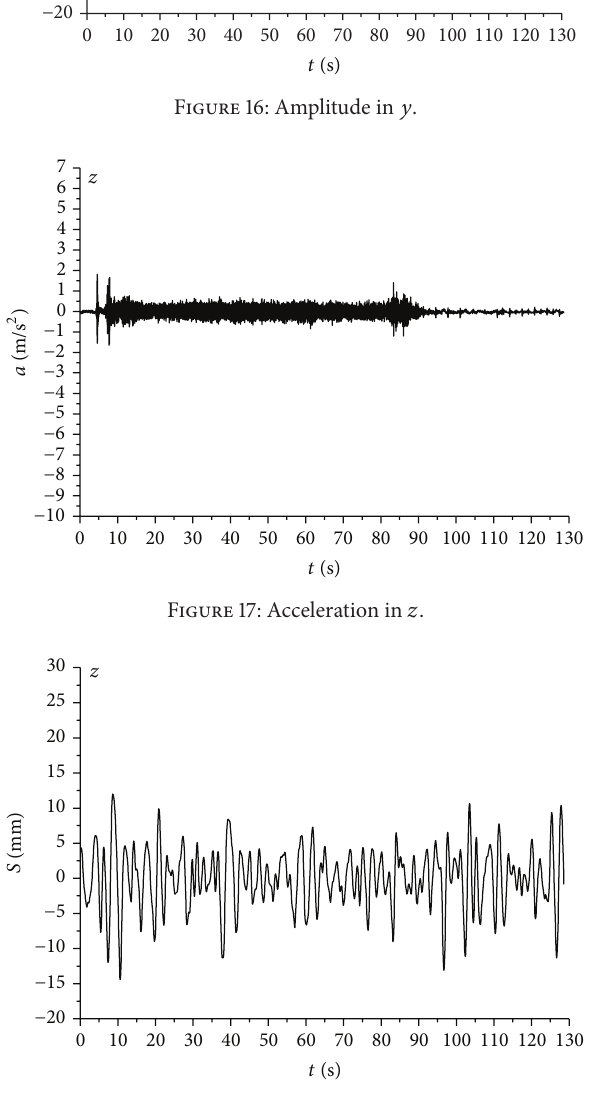
Figure 16: Amplitude in 𝑦 .